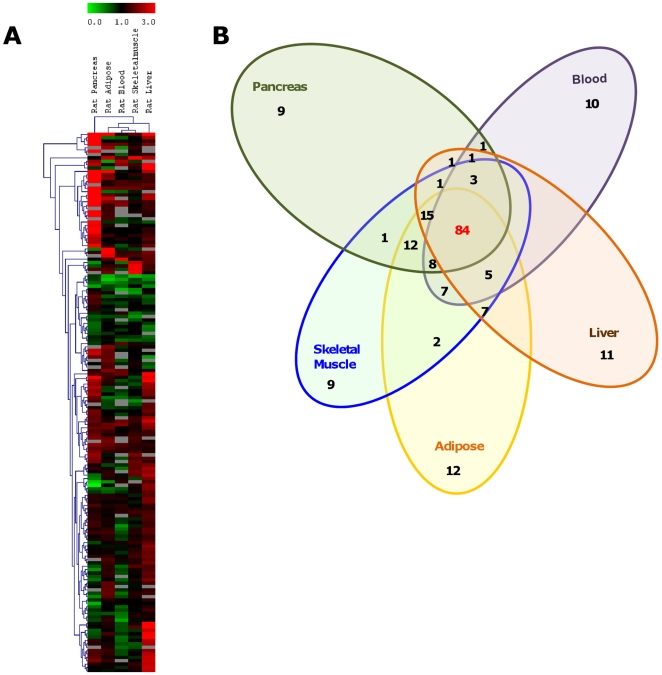
Clustering of miRNA profiles of blood and tissues of HFD rats.
A.
 Hierarchical clustering plot (heatmap) of miRNA distribution in blood and tissues of HFD rats (compared to controls). Only miRNAs conserved in humans with background subtracted mean signal intensities above 300 are included. Expression of blood miRNAs are clustered in the centre closely to the peripheral tissues. Data are expressed as fold change of HFD versus NFD control. Green: down-regulation; Red: up-regulation; Grey: not detected. B.
 Venn diagram showing the number of miRNAs with significant changes detected in blood and the different tissues (Diabetic vs controls). 84 miRNAs have been detected in all five sources.